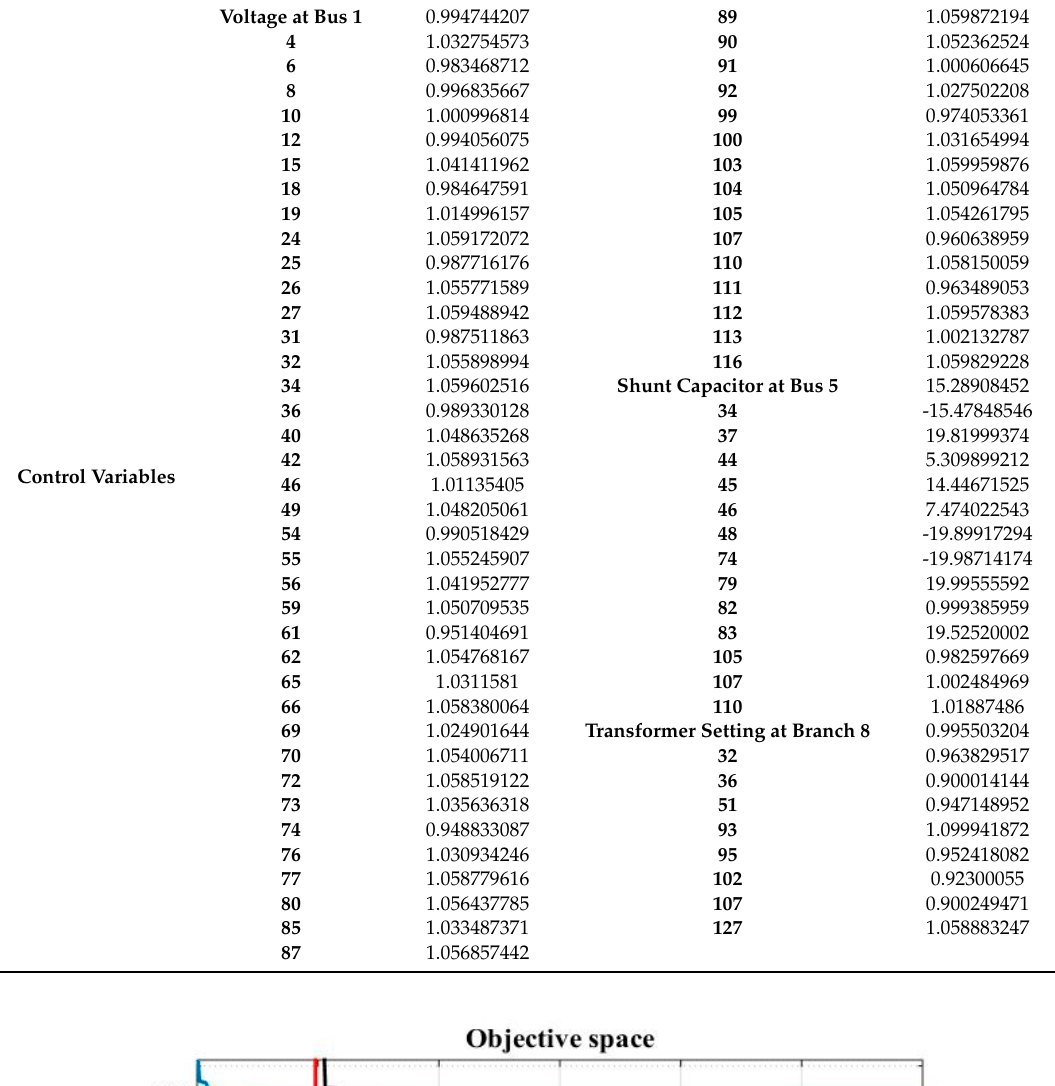
Table 12. 118-bus system decision variables for the second case.